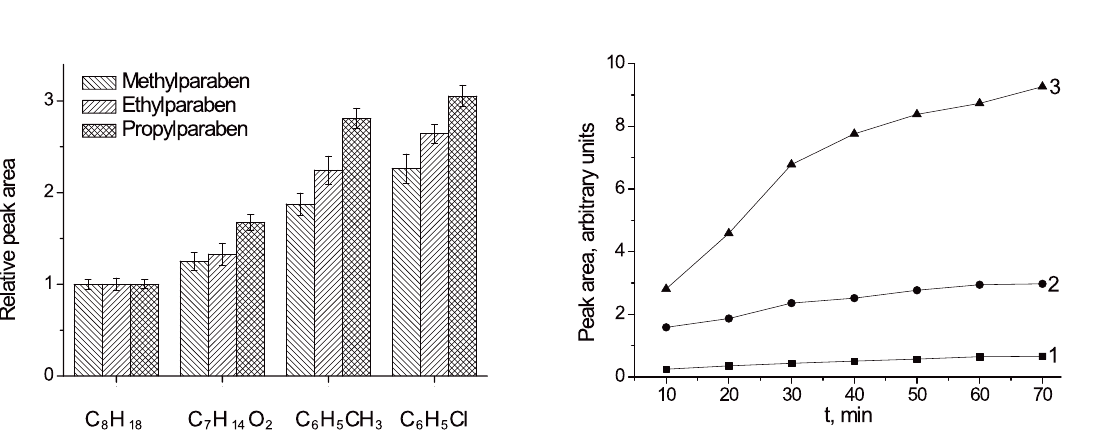
Figure 1. Effect of HFLPME solvent on methylparaben, ethylparaben Figure 2. Effect of HFLPME time on the peak areas of (1) methylparaben, and propylparaben peak areas. Concentration of each (2) ethylparaben and (3) propylparaben. Concentration of analyte is 5 µg mL -1 . Extraction time is 15 min. Solution each analyte is 5 µg mL -1 . Solution stirring rate is 1500 stirring rate is 1500 rpm. Peak areas normalised to the corresponding peak areas of C H . 14 30